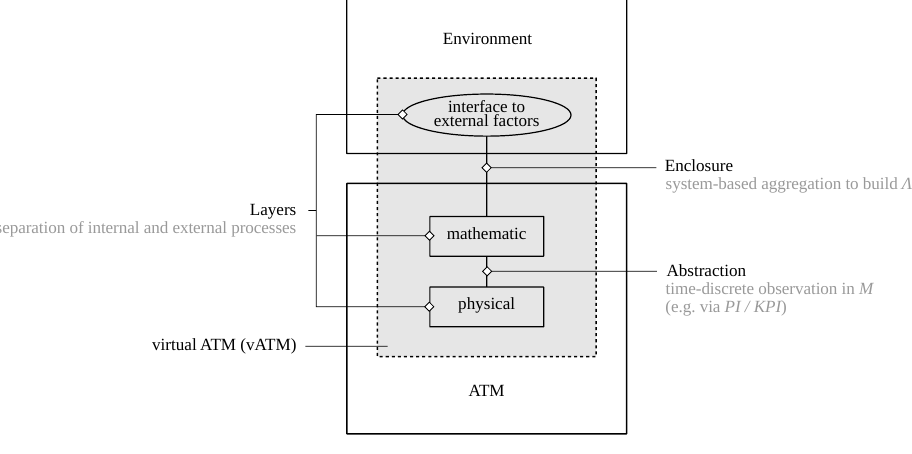
Figure 4. The virtual Air Traffic Management ( vATM ) and its three basic modules.